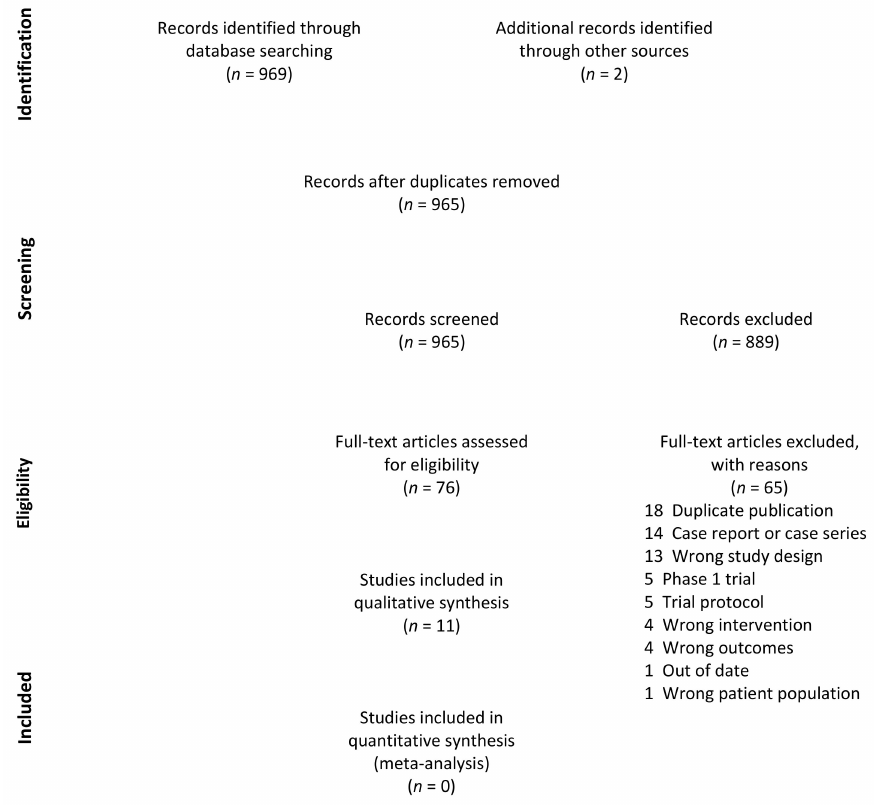
Figure 1. PRISMA flow